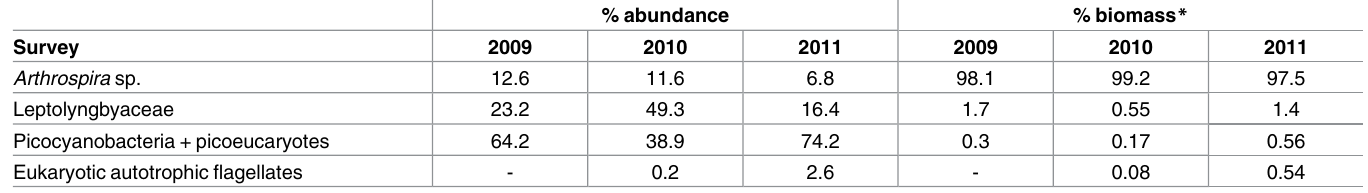
% abundance % biomass *